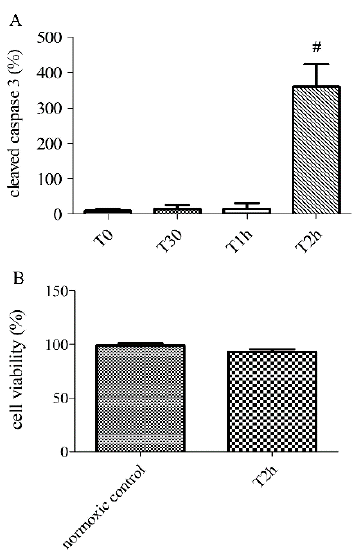
Figure 2. Apoptosis at different time-points of hypoxia (0, 30 min, 1 and 2 h) and cell viability after 0 (normoxic control) or 2 h of hypoxia (T2h), determined by the relative expression of cleaved caspase-3 by immunoblotting ( A ) and PrestoBlue assays ( B ). Results are expressed as means ± sem ( n = 6/group). #: p < 0.05, compared to normoxic control.